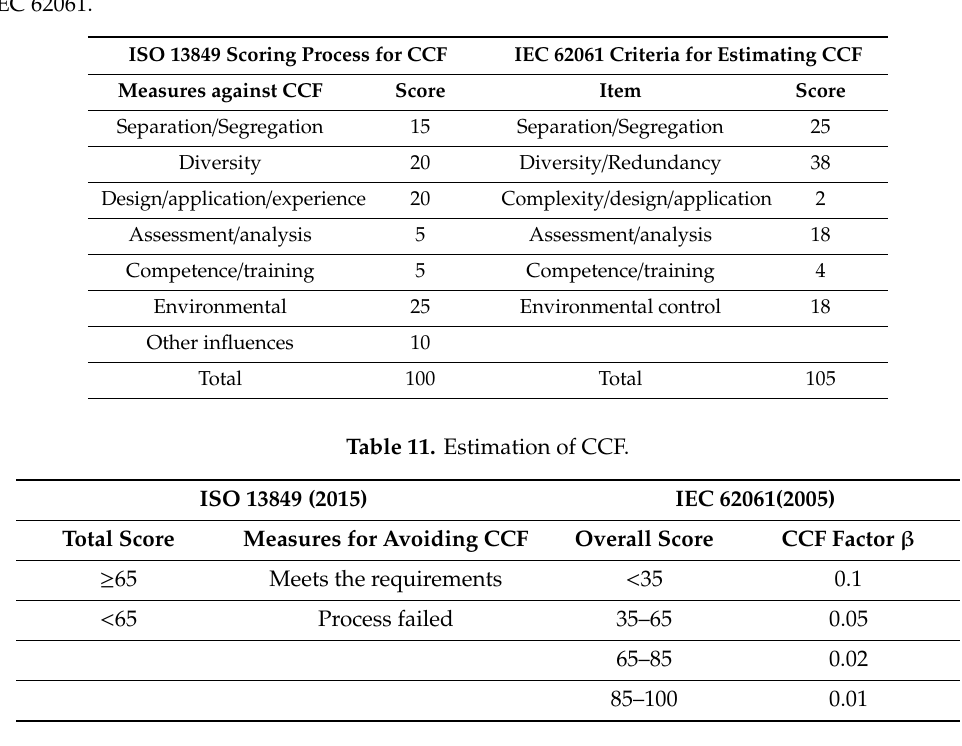
Table 10. Scoring process for measures against Common Cause Failure (CCF) from ISO 13849 and IEC 62061.